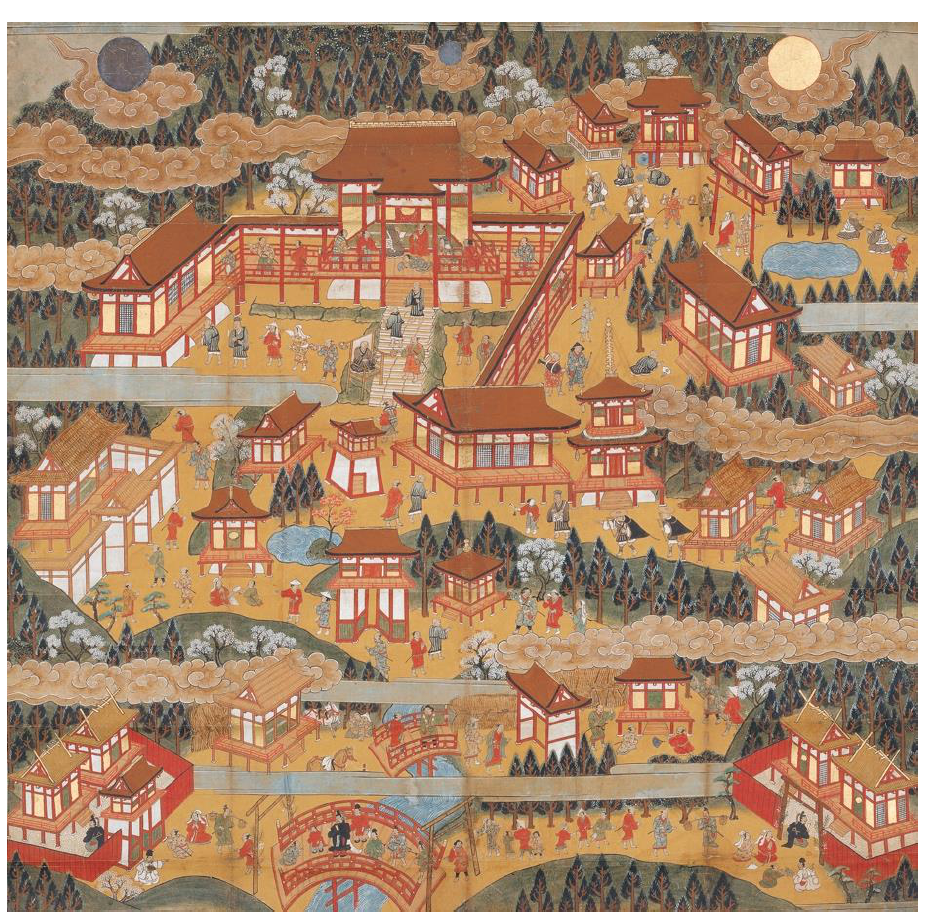
Figure 8. Kongōshōji Ise Pilgrimage Mandala , early 17th century, hanging scroll, ink and colors on paper. 146.2 × 150.4 cm. Yoshiminedera, Kyoto.